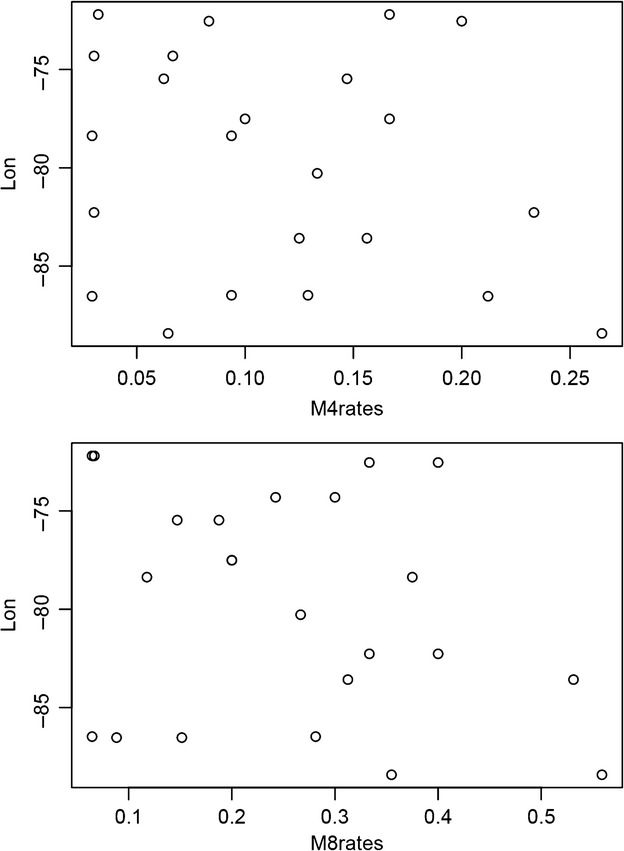
Short-term (top) and long-term (bottom) remating rates of females plotted against longitude.